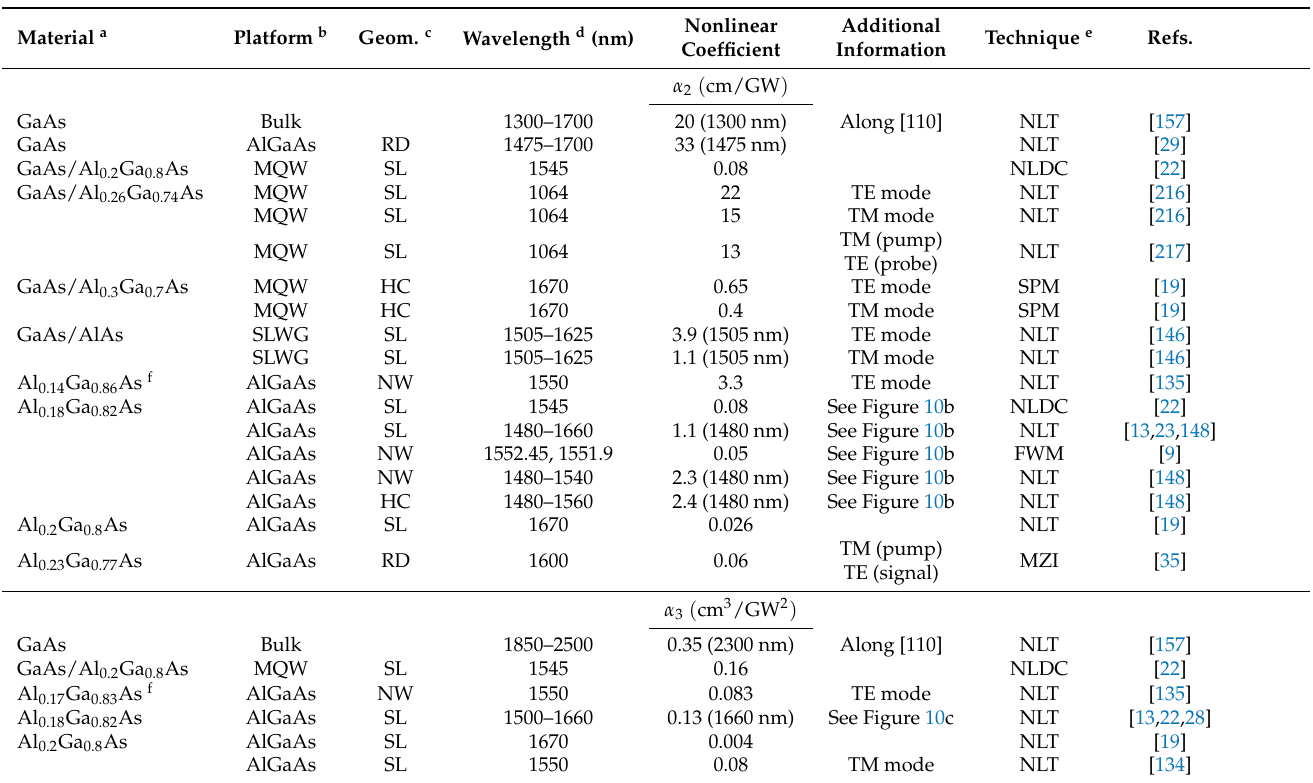
Table 6. Nonlinear absorption